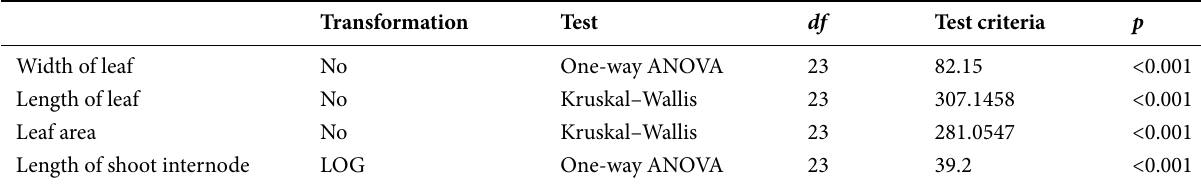
Table 2 Statistical evaluation of differences in morphological parameters of Potamogeton praelongus leaves and